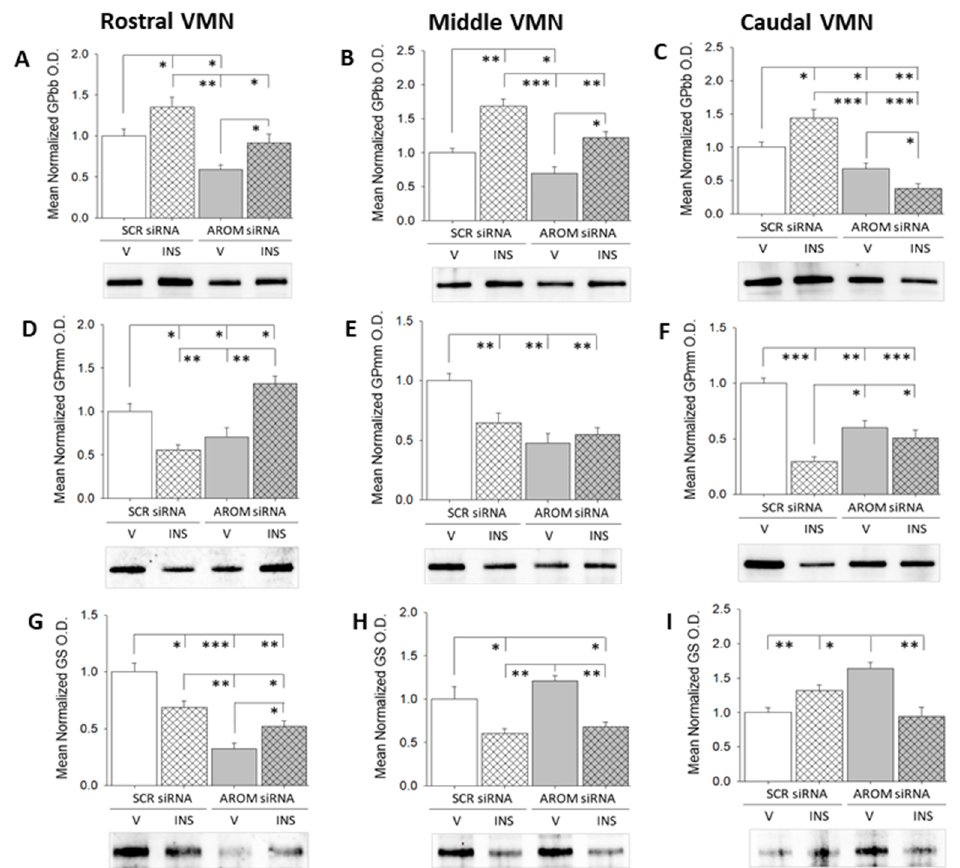
Figure 3. Eu- and hypoglycemic patterns of VMN glycogen metabolic enzyme protein expression in SCR versus aromatase siRNA-pretreated male rats. Data depict mean normalized glycogen phos- phorylase (GP)-brain type (GPbb; ( A – C )), GP-muscle type (GPmm; ( D – F )), and glycogen synthase (GS; ( G – I )) protein O.D. values + S.E.M. for SCR siRNA/V (solid white bars; n = 4), SCR siRNA/INS (diagonal-striped white bars; n = 4), AROM siRNA/V (solid gray bars; n = 4), AROM siRNA/INS (diagonal-striped gray bars; n = 4) treatment groups. * p < 0.05; ** p < 0.01; *** p < 0.001.